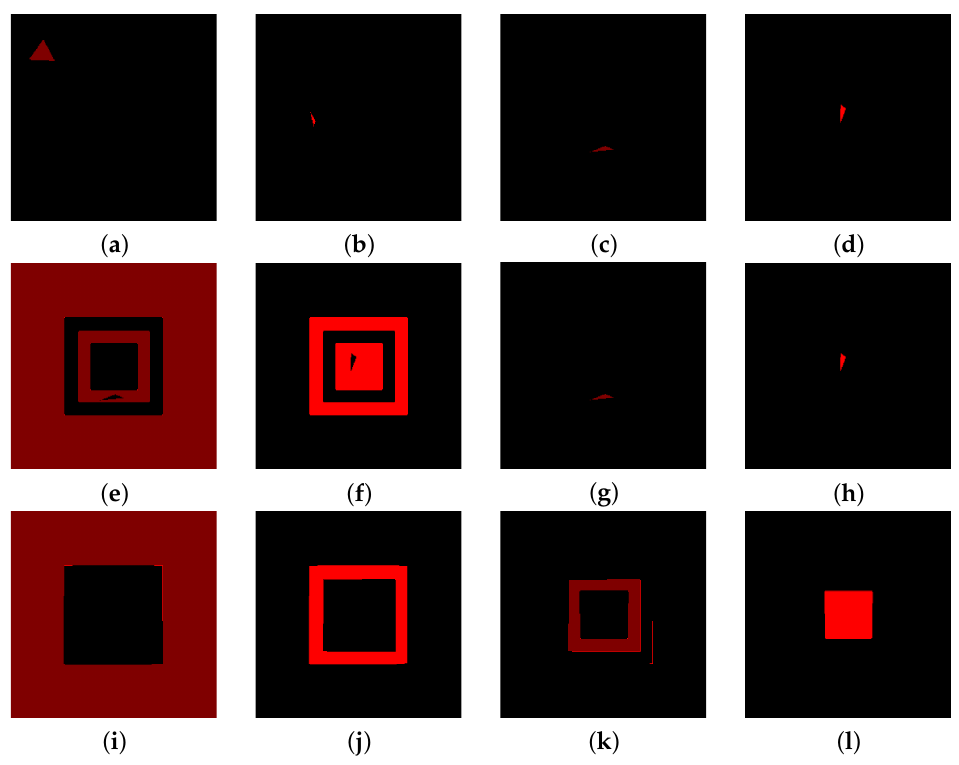
Figure 7. ( a – d ) marked regions for the labelling of the four different objects. ( e – h ) results provided by the employment of the sole similarity index. ( i – l ) results of the proposed procedure. In the last case, the objects are fully